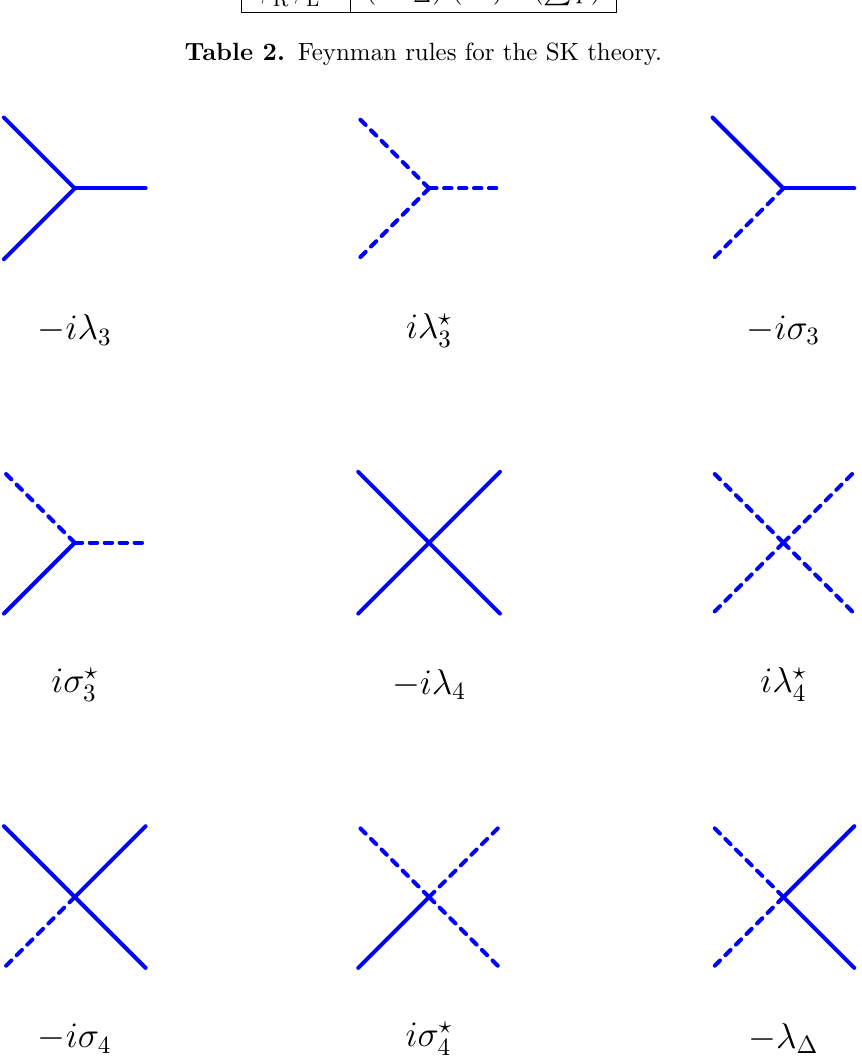
Figure 3. Diagrammatic Representation of all the Tree level